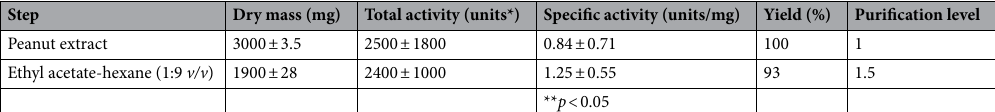
Table 1. Silica gel column chromatography of a hexane extract of peanut. Mean values and standard errors obtained from duplicate measurements are presented in the table. *1 unit = the dose that makes the OD 492 value of 0.425. **The p value obtained from Student’s t -test for the specific activities for the two fractions is